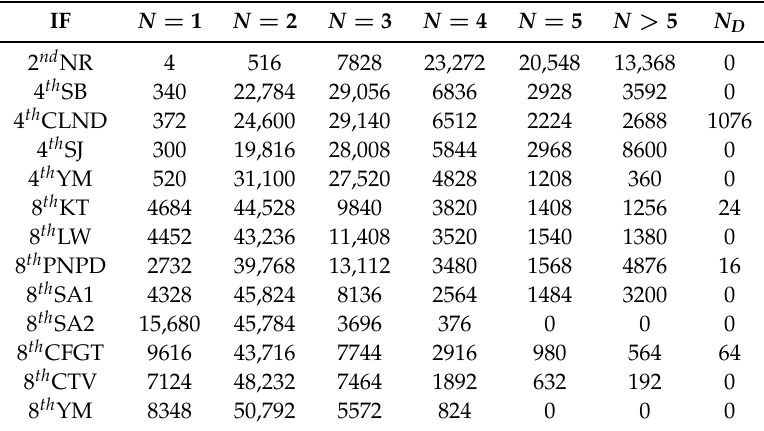
Table 8. Results of the polynomials p 1 ( z ) = z 2 − 1.